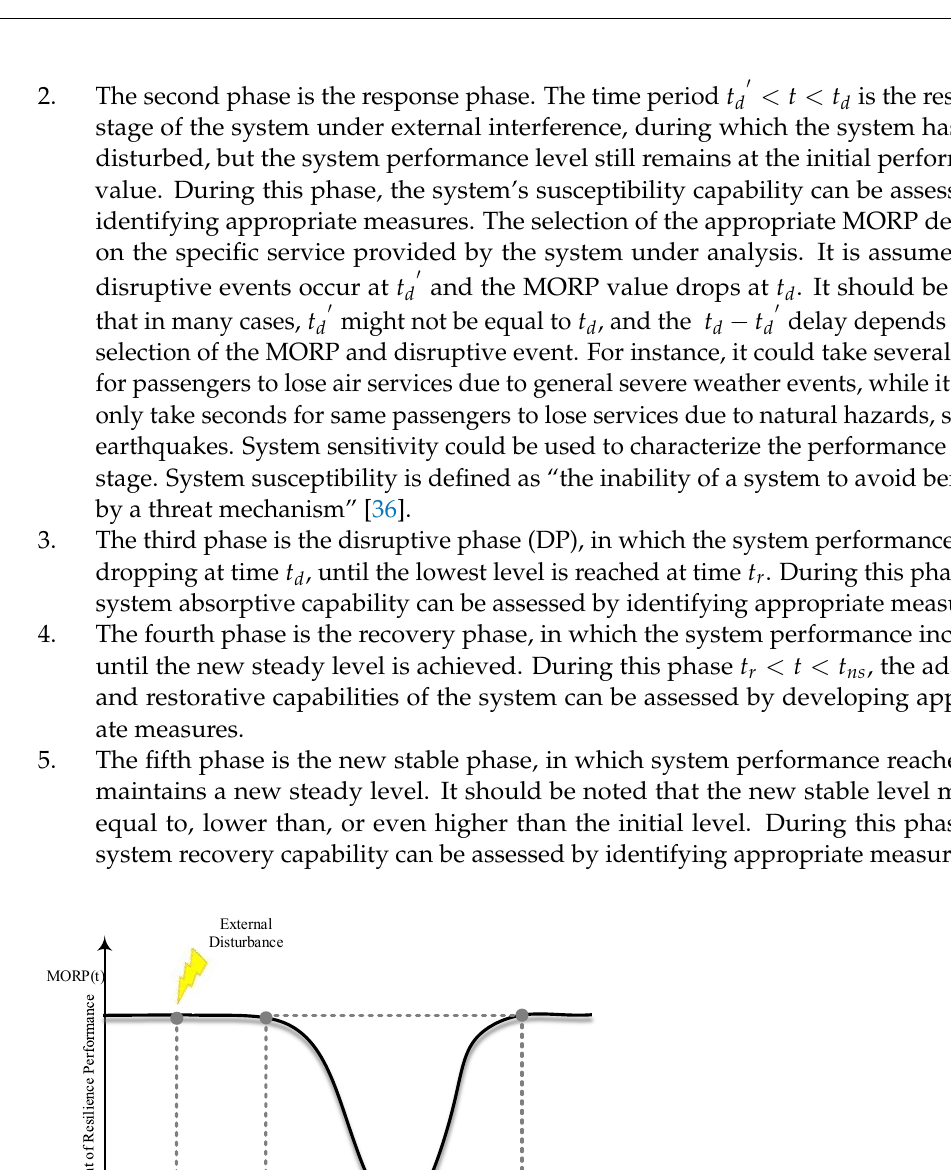
t time indicates the mo- d